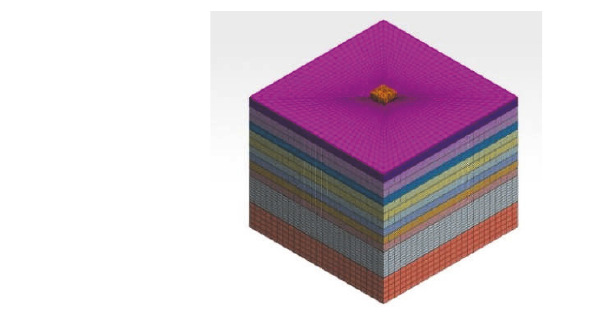
Figure 6: FE model of cap-pile-soil system.